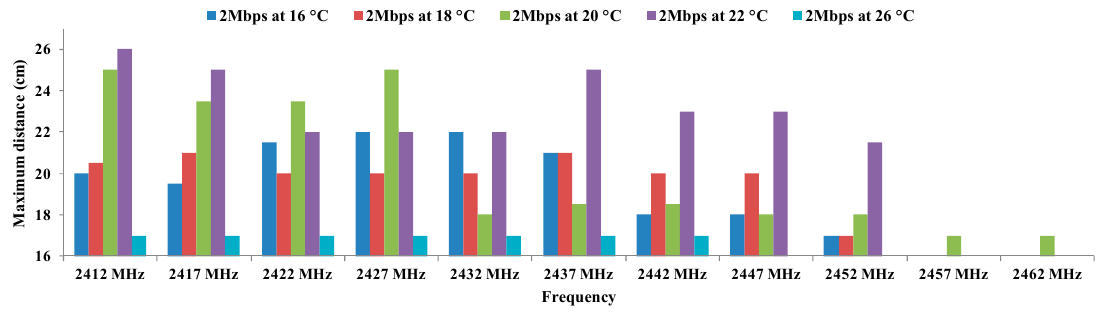
Figure 9. Maximum distances for QPSK.